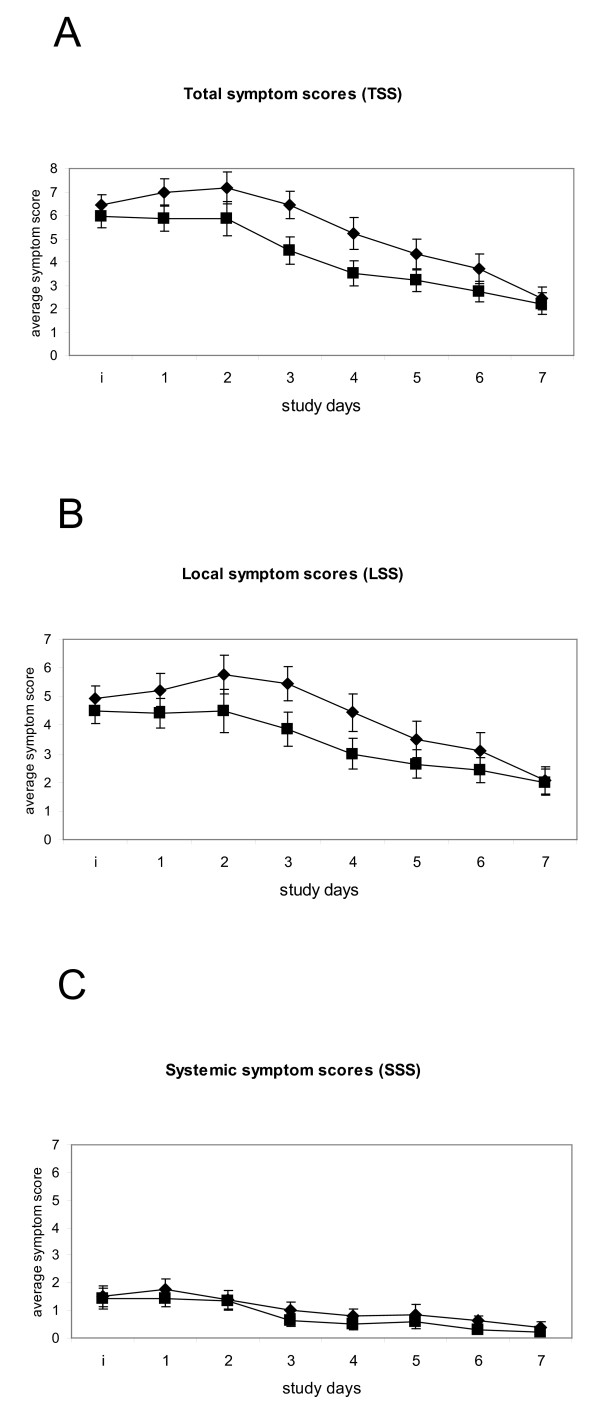
Mean symptom scores over 7 days. Mean ± SEM for Carrageenan nasal spray (black squares) and Placebo (black triangles) treatment groups. A. Total symptom scores B. Local Symptom scores C. Systemic symptom scores. The y axis shows the study day; i indicates the point of inclusion into the study.